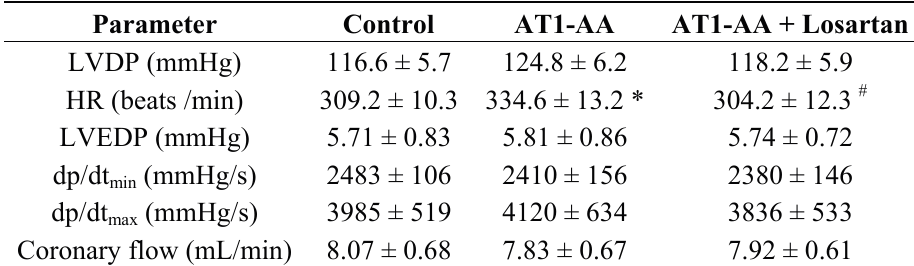
Table 1. Pre-ischemic LV (left ventricular) function parameters.